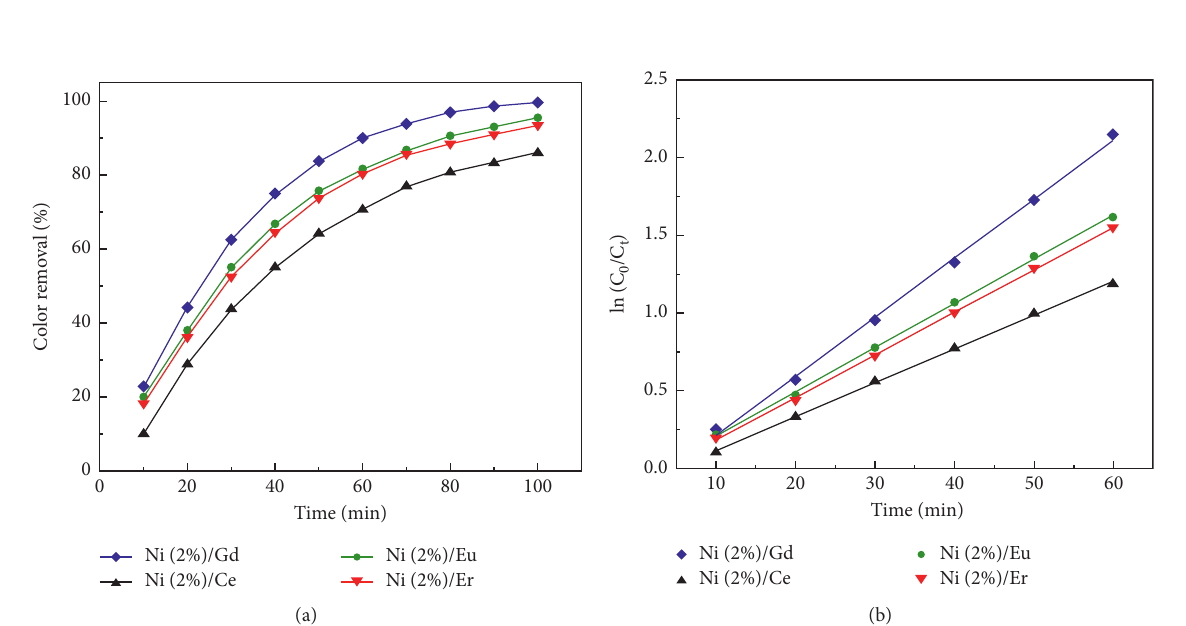
Figure 15: Electrochemical decolorization performance at Ti/SnO content. (a) Decolorization efficiency. (b) Kinetic analysis of the curves (RhB concentration: 100mg · L − 1 ; current density: 10 mA · cm − 2 ; supporting electrolyte: 0.1 mol · L − 1 Na 2 SO 4 ; 25 ° C).